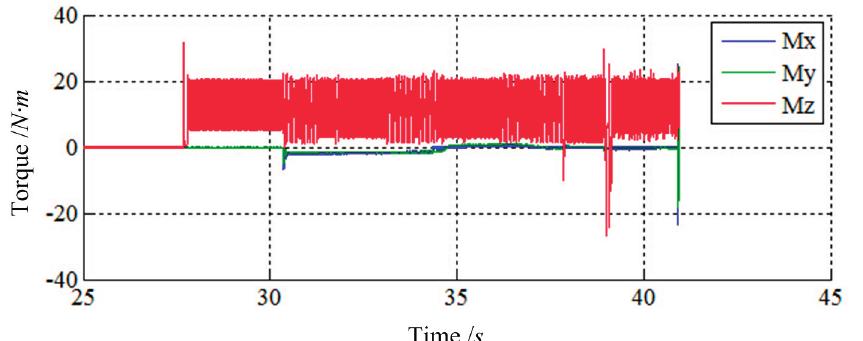
Figure 16. The force tracking results of Case